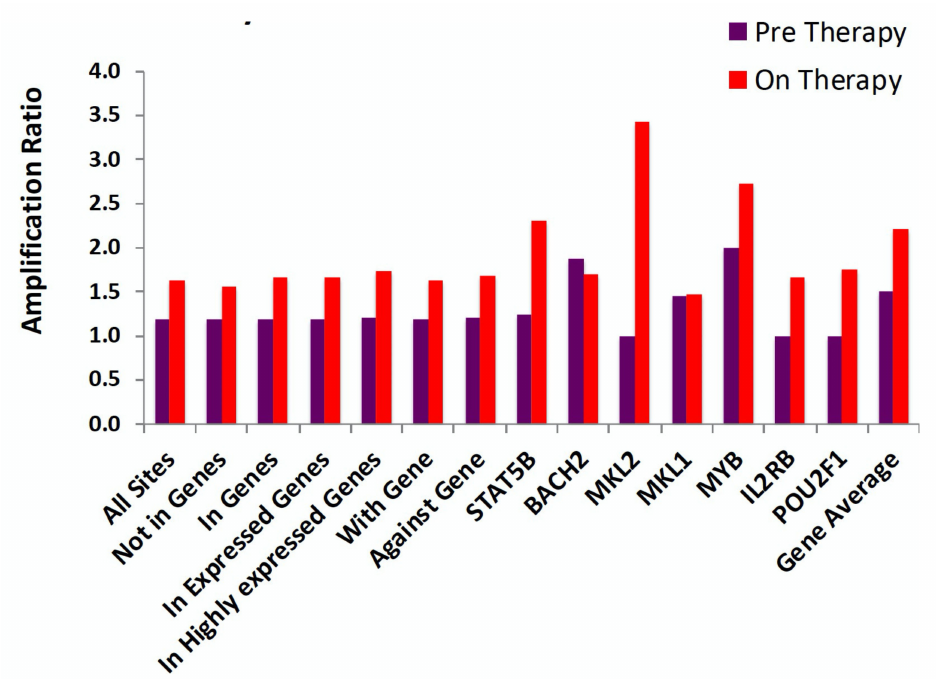
Figure 8. Clonal amplification is independent of integration site location or provirus orientation. Pooled integration site data from pre- and on-ART samples were divided into the groups shown, and the amplification ratio was calculated using the total number of breakpoints in each group divided by the total number of unique integration sites. None of the differences are statistically significant. Reprinted from